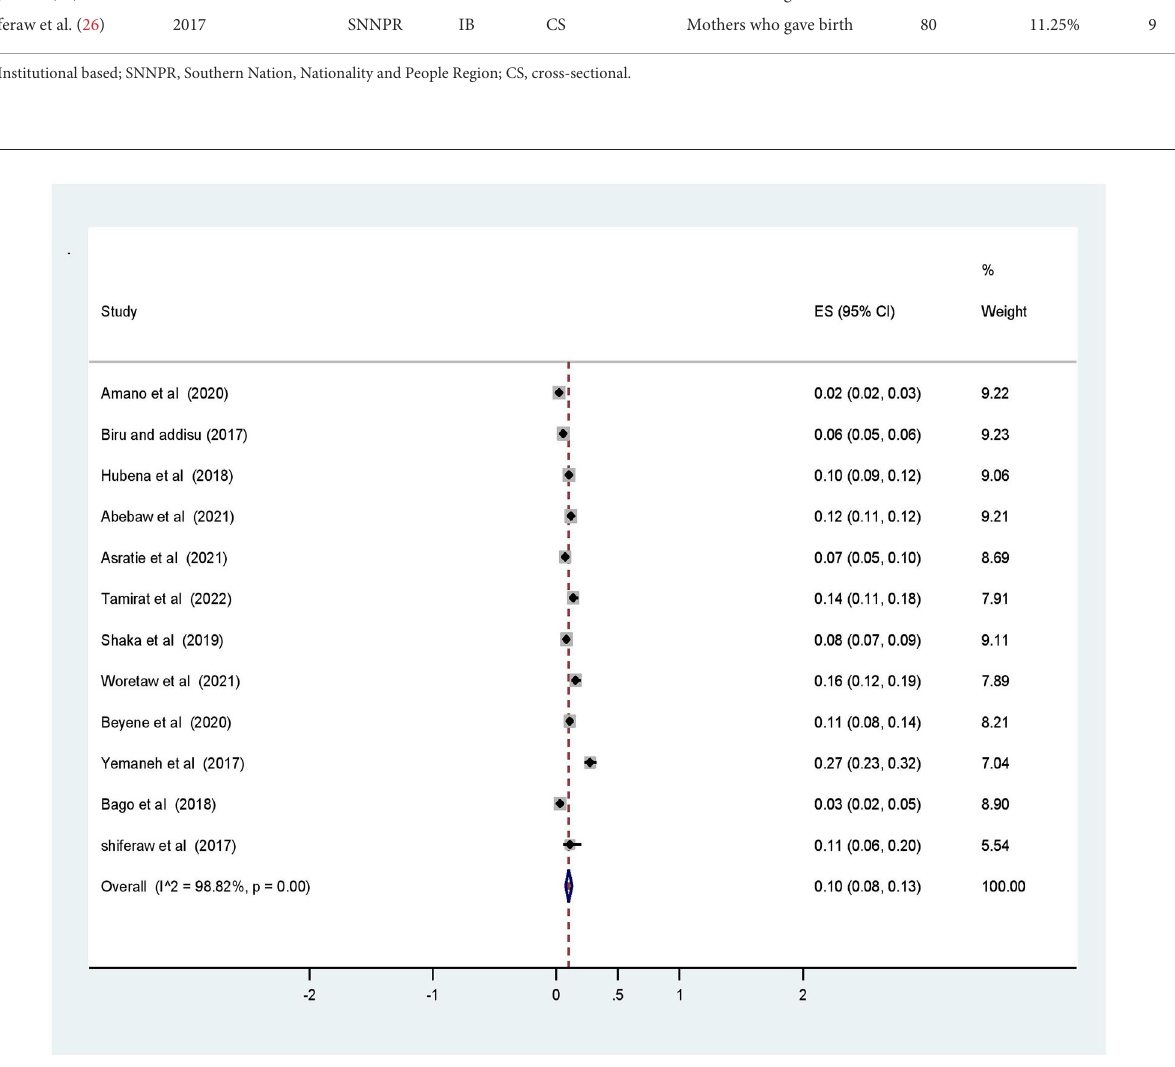
FIGURE2 Forest plot of the pooled prevalence of operative vaginal deliveries among mothers who gave birth in Ethiopia,